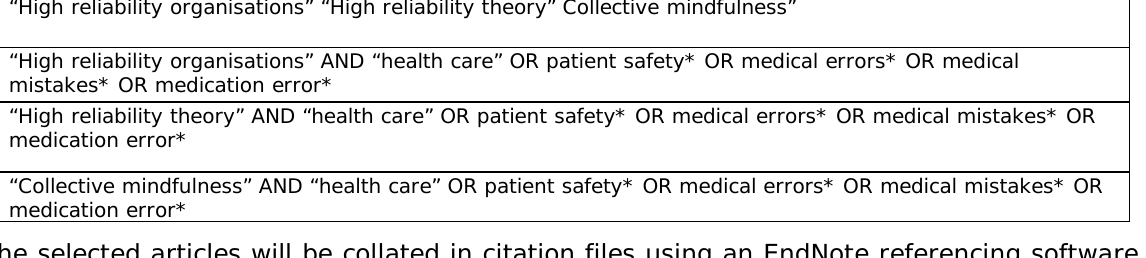
Table 1. Keywords to be